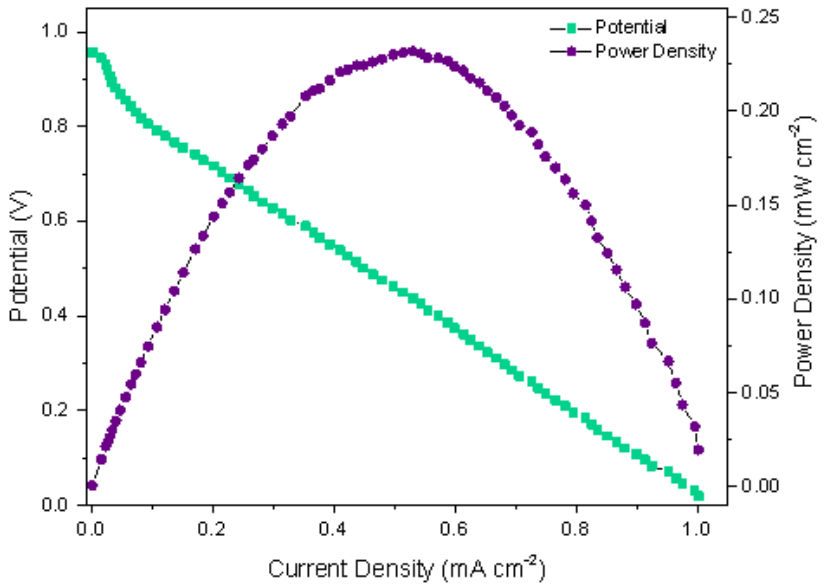
Figure 3. Polarization and power density curves of the air-breathing paper-based µFC with TiO 2/ Ni anode and Pt/C cathode inside the qualitative pregnancy test using human urine as